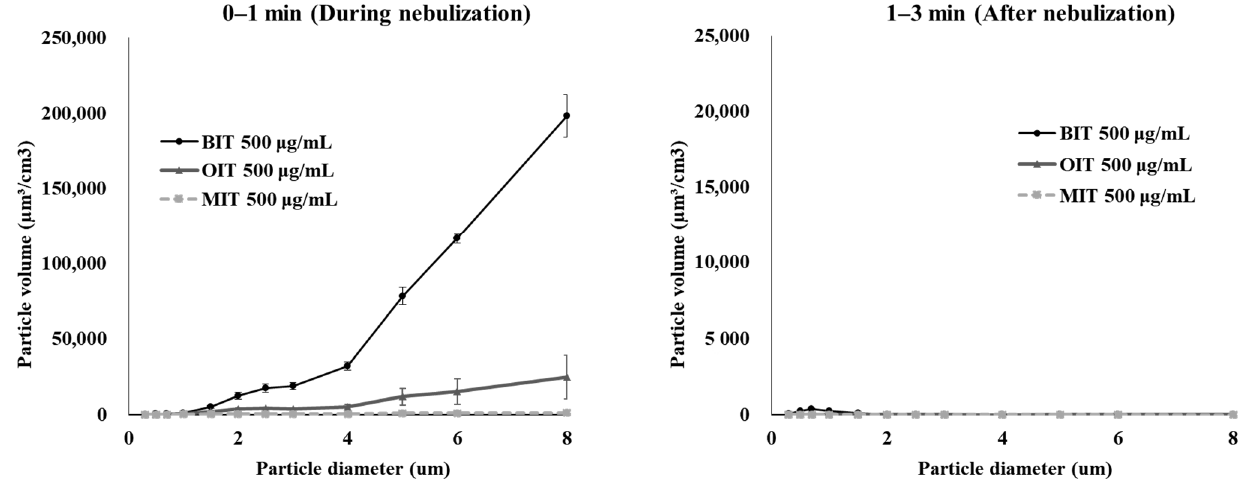
Figure 6. Particle distribution of BIT, MIT, and OIT aerosols in volume measured in an in-house-built exposure chamber. Table 1. The fraction of the particle number and the volume of biocide aerosols during the